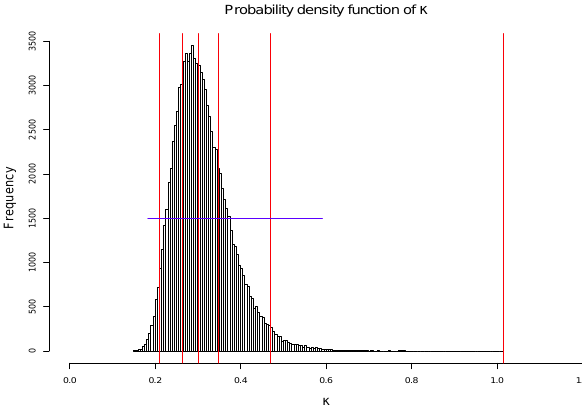
Fig. 5. The uncertainty distribution of one (cid:20) measurement, produced by 100000 Monte Carlo samples. Red Figure 5. The uncertainty distribution of one κ measurement, pro- vertical lines from left to right depict the the 2.5, 25, 50, 75, 97.5 and 100th percentiles; blue horizontal line duced by 100000 Monte Carlo samples. Red vertical lines from left to right depict the 2.5, 25th, 50th, 75th, 97.5 and 100th percentiles; illustrates the range of the original error bars. blue horizontal line illustrates the range of the original error